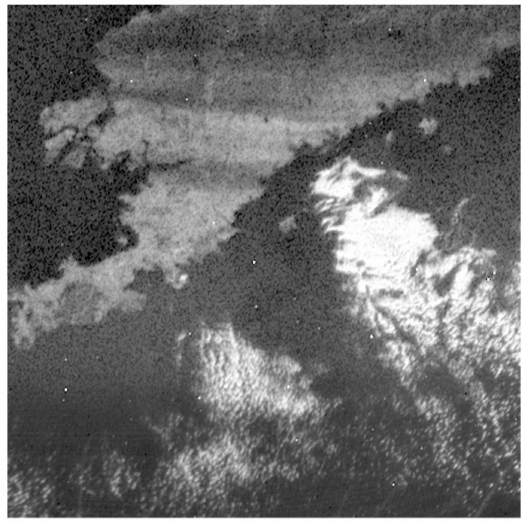
Figure 15. Example of the MIR band of the GF-4 imagery for the Liaoning Sea study